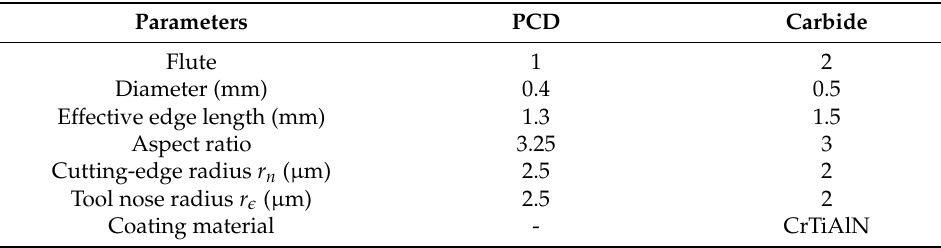
Table 3. Geometric parameters of LAR PCD and carbide cutters.